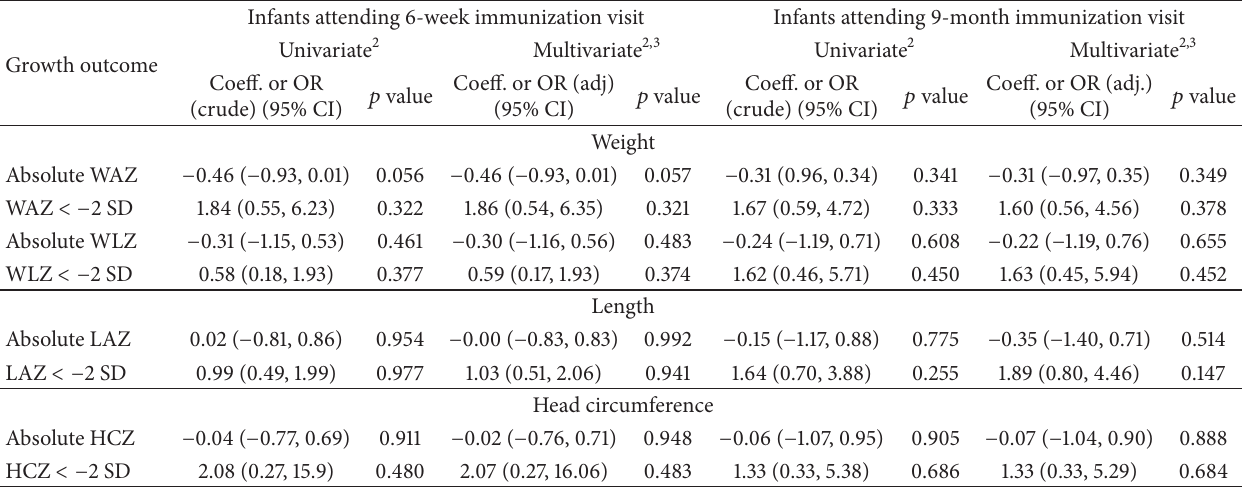
Table3:Associationofageandsex-adjusted 𝑧 -scoresforweight,weight-for-length,length,andheadcircumference(HC)amongHEUinfants and maternal TDF use in pregnancy, by 6-week and 9-month immunization visits 1 .